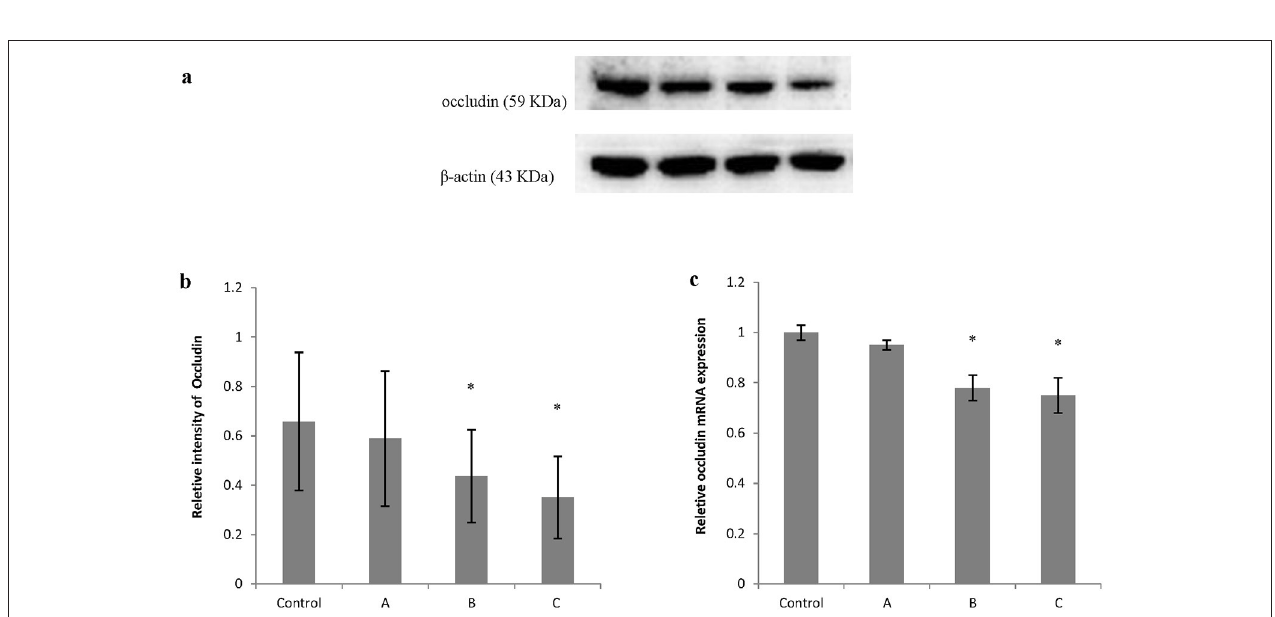
FIGURE 6 | Comparison of occludin protein and mRNA levels in mouse brain among groups. The number of mice used for Western blots and real-time RT-PCR were 10 in control, 9 in group A, 8 in group B, and 8 in group C. Data were given as mean ± SD , and analyzed by one-way ANOVA. Significant difference was defined as P < 0.05, * vs. control group. (a) Western blot analysis; (b) Densitometric analysis of Western blots; (c) Quantitation of mRNA by real-time RT-PCR. The mRNA levels were normalized to GAPDH and presented as fold change vs. control